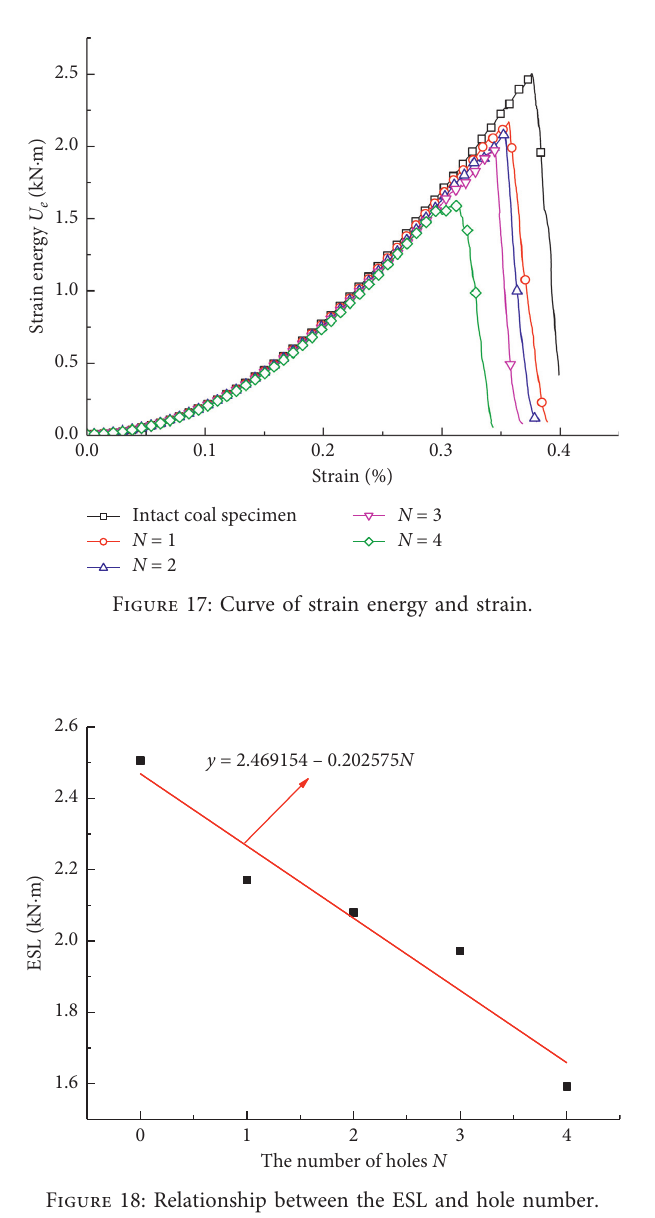
Figure 20: Curve of crack number and